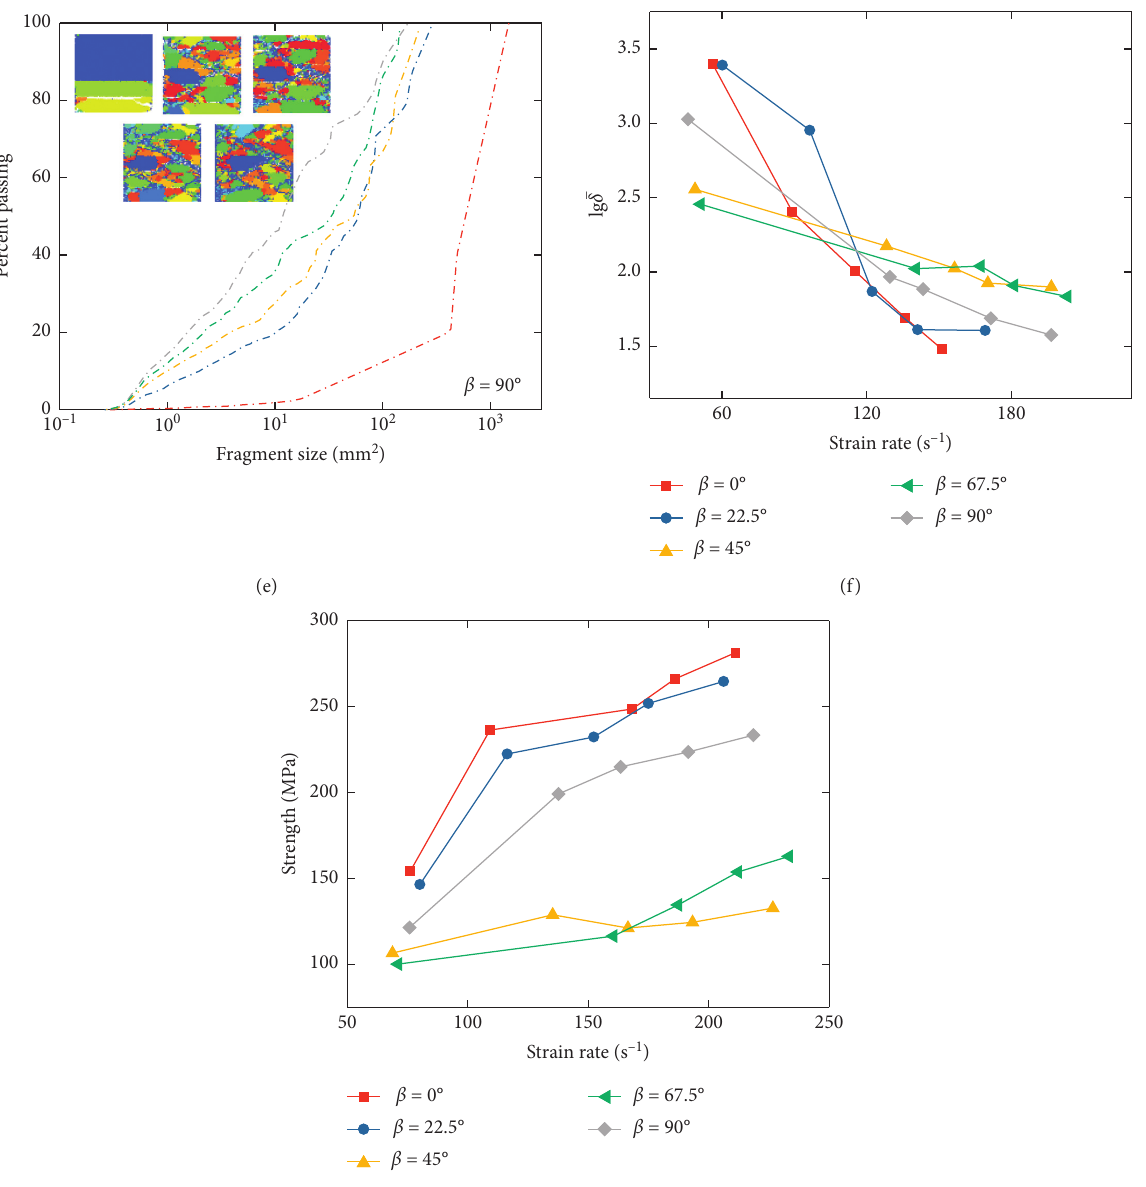
Figure 8: The cumulative distribution curve and average fragment size of layered rocks under different strain rates. (a–e) The distribution curve of 0 ° , 22.5 ° , 45 ° , 67.5 ° , and 90 ° samples, red: _ ε ≈ 80s − 1 , blue: _ ε ≈ 140s − 1 , yellow: _ ε ≈ 170s − 1 , green: _ ε ≈ 200s − 1 , and gray: _ ε ≈ 215s − 1 . (f) Average fragment size vs. strain rate under different bedding angles. (g) Dynamic strength vs. strain rate under different bedding